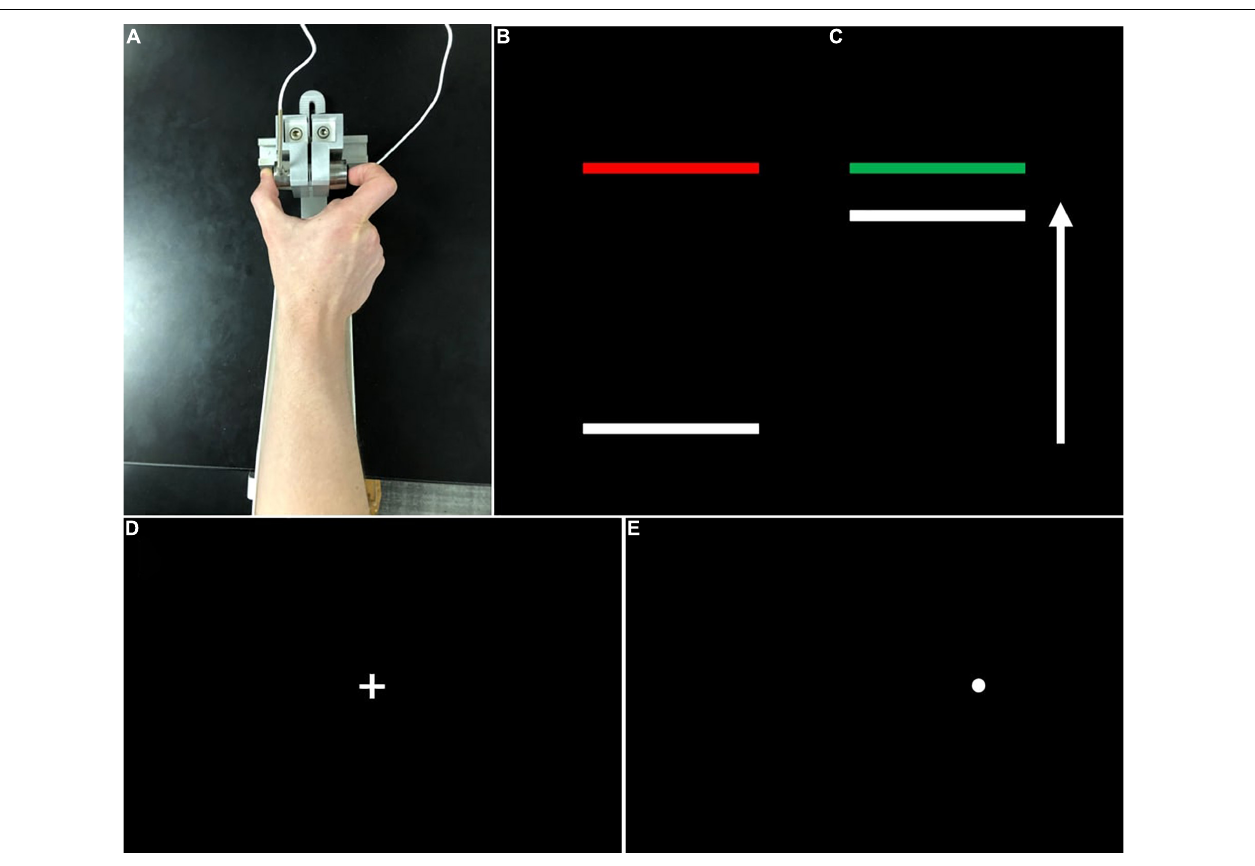
FIGURE 1 | (A) Grip configuration and load cells for precision grip testing. Participants pressed with their thumb and forefinger against two precision load cells. Participants pressed the load cells as quickly as possible when the red target bar (B) turned green (C) and continued pressing to maintain the force bar steady at the level of the green target bar. (D) During visually guided saccade testing, participants fixed their gaze on a centrally located crosshair at the start of each trial, then looked quickly toward (E) peripheral targets (i.e., white circles) which appeared pseudorandomly at ± 12 ◦ or 24 ◦ of visual